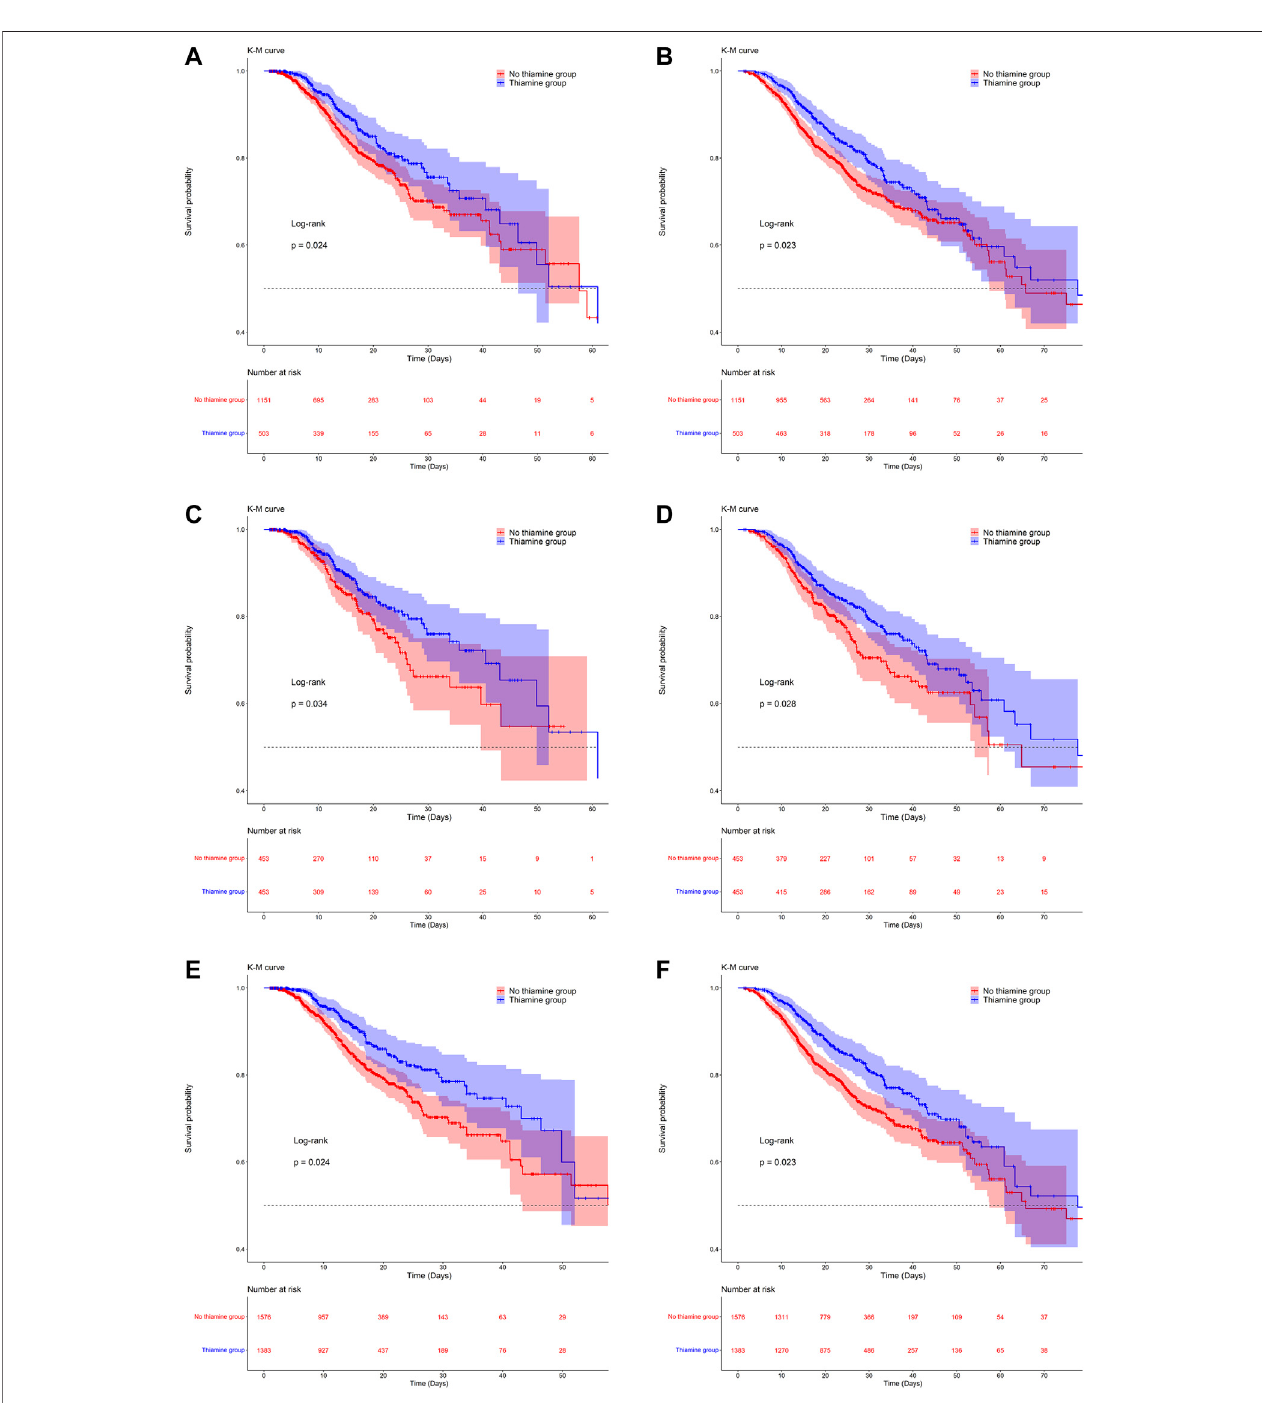
FIGURE 2 | Kaplan-Meier survival curves between groups. a, c and e are the ICU mortality risk for the original population, the PSM population and the IPW population; b, d, and f are the in-hospital mortality risk for the original population, the PSM population and the IPW population.